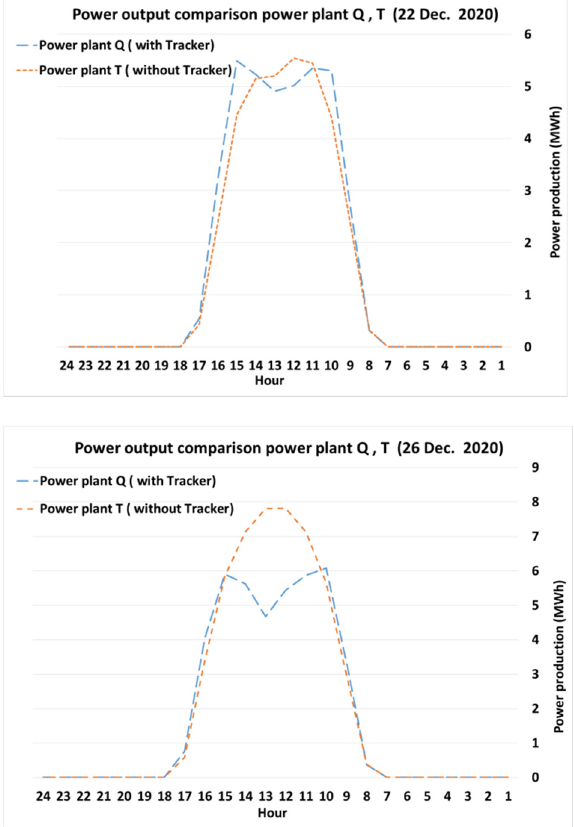
Figure 5. Comparing the daily energy production of two power plants, Q and T, on 22 December and 26 December.